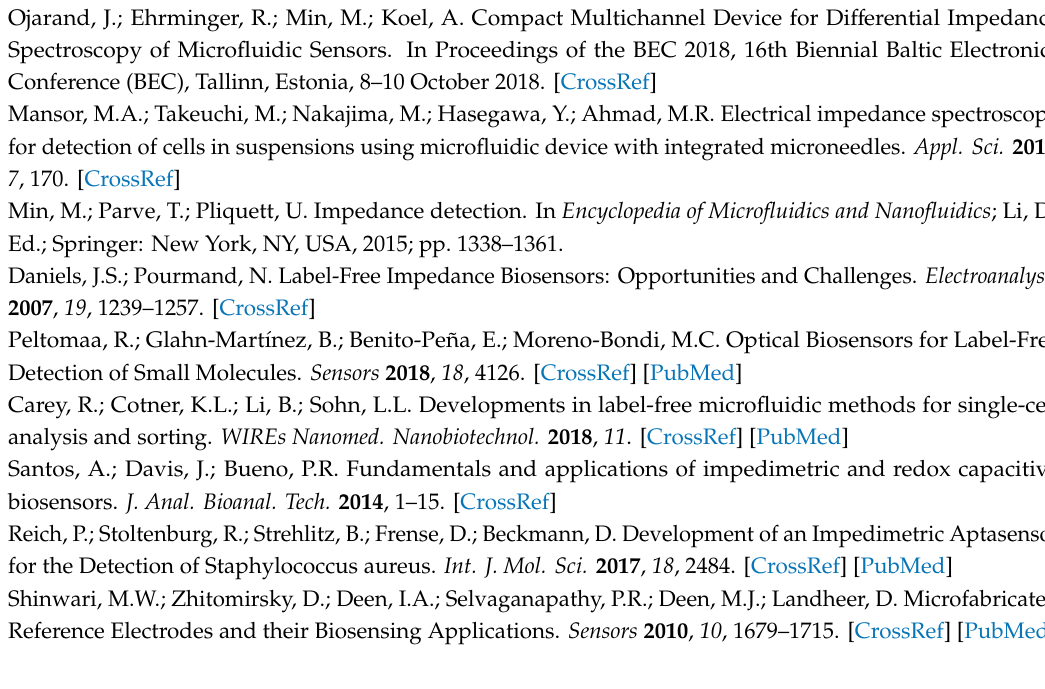
Figure A11. Impedance phase variations of the SUT1 measured with the Wayne Kerr analyzer ( a ) and the developed analyzer ( b ).